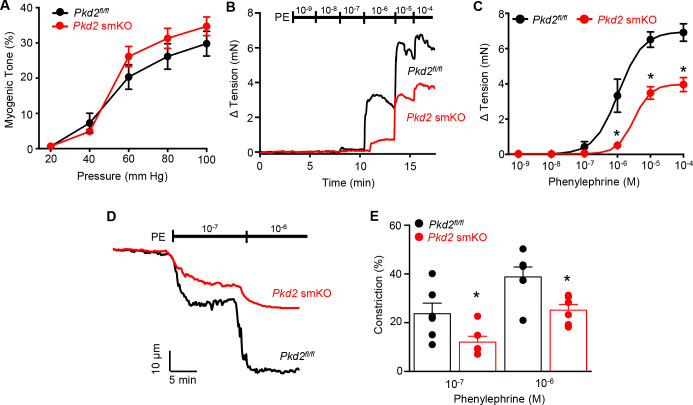
Pressure-induced vasoconstriction is unaltered, whereas phenylephrine-induced vasoconstriction is attenuated, in mesenteric arteries of Pkd2 smKO mice.(A) Mean vasoconstriction over a range of pressures in resistance-size mesenteric arteries from Pkd2fl/fl (n = 7) and Pkd2 smKO (n = 9) mice. (B) Original recordings of concentration-dependent, phenylephrine (PE)-induced contraction in mesenteric artery rings. (C) Mean PE-induced contraction (Pkd2fl/fl, n = 5; Pkd2 smKO, n = 6; *p<0.05 versus Pkd2fl/fl). (D) Representative phenylephrine-induced vasoconstriction in pressurized (80 mmHg) fifth-order mesenteric arteries. (E) Mean PE-induced vasoconstriction in pressurized (80 mmHg) fourth-and fifth-order mesenteric arteries (Pkd2fl/fl, n = 6; Pkd2 smKO, n = 6; *p<0.05 versus Pkd2fl/fl at the same PE concentration).